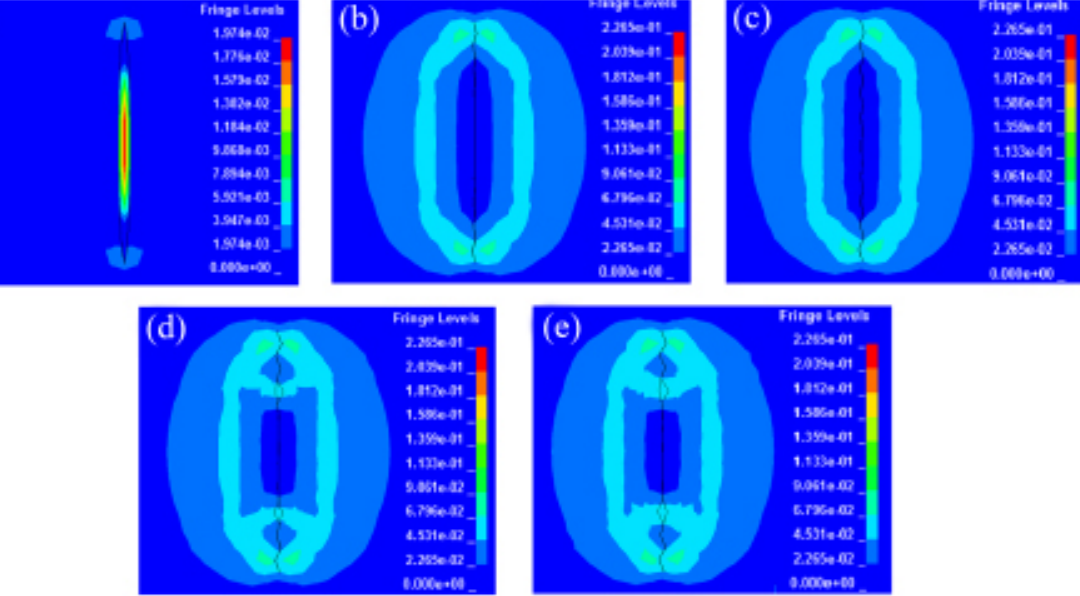
Figure 3. Strain variation and microcrack width versus time (the unit of the quantities in the Figure is system of electromagnetic units) ( a ) 26 us; ( b ) 82 us; ( c ) 138 us; ( d ) 192 us; ( e ) 400